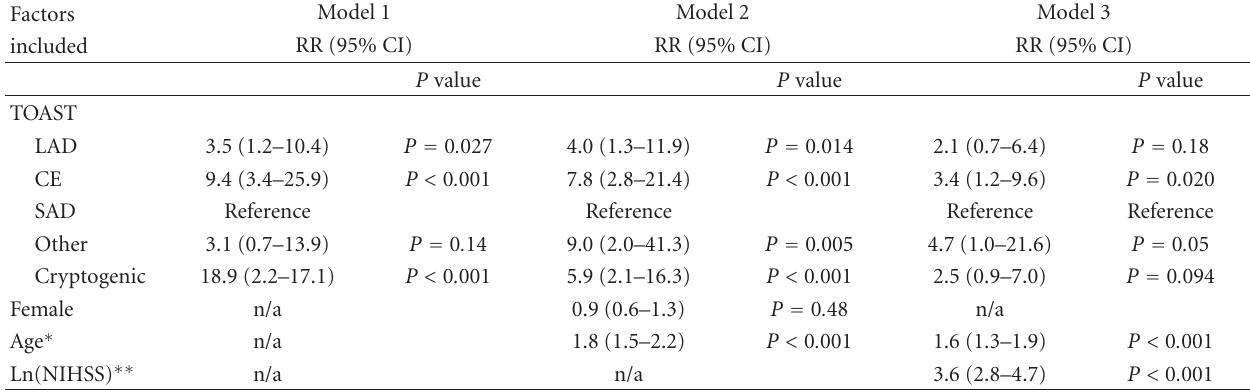
Table 3: Risk ratios of mortality.